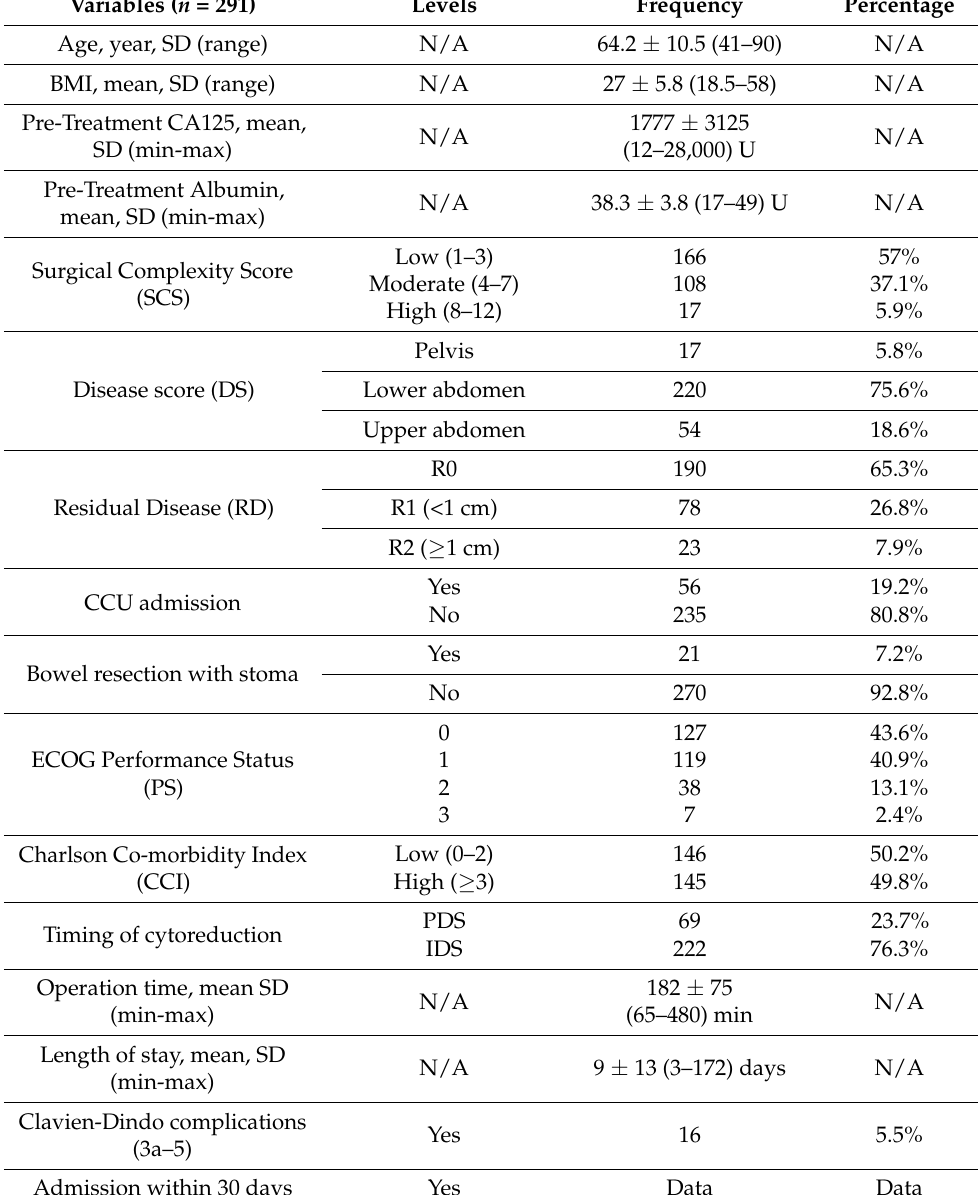
Table 1. Pre-operative, intra-operative and post-operative parameters of the study